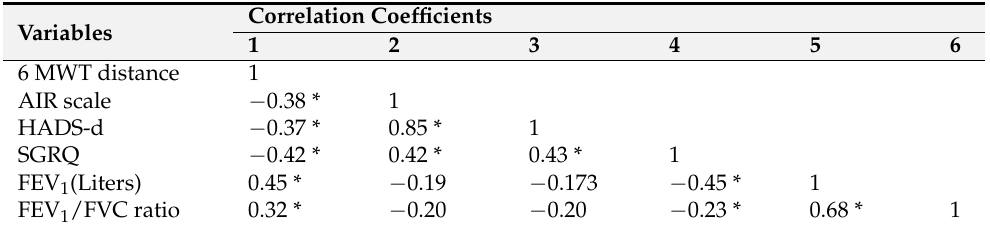
Table 3. A Matrix of the Pearson correlation between the Walking Performance, and personal psychological characteristics among the study respondents.